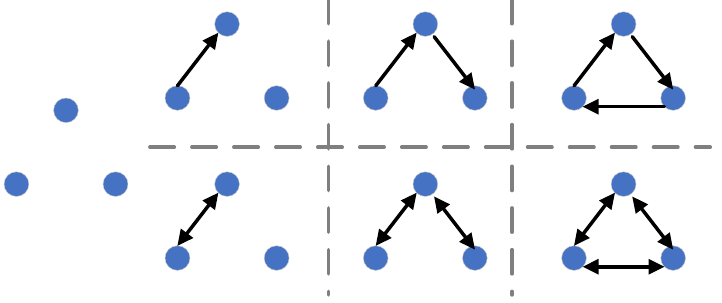
Figure 3. Relationship between nodes and edges in the ECETN model.